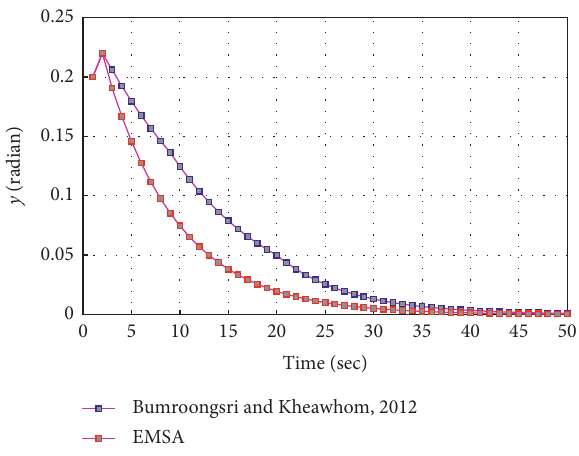
Figure 8: The regulated output obtained with EMPS